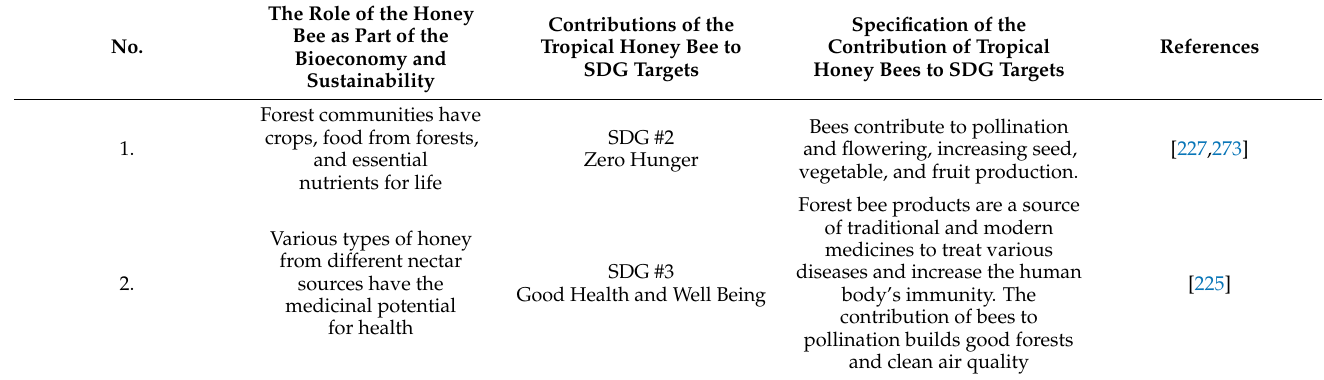
Table 3. Contribution of tropical honey bees on bioeconomy and sustainable development goals